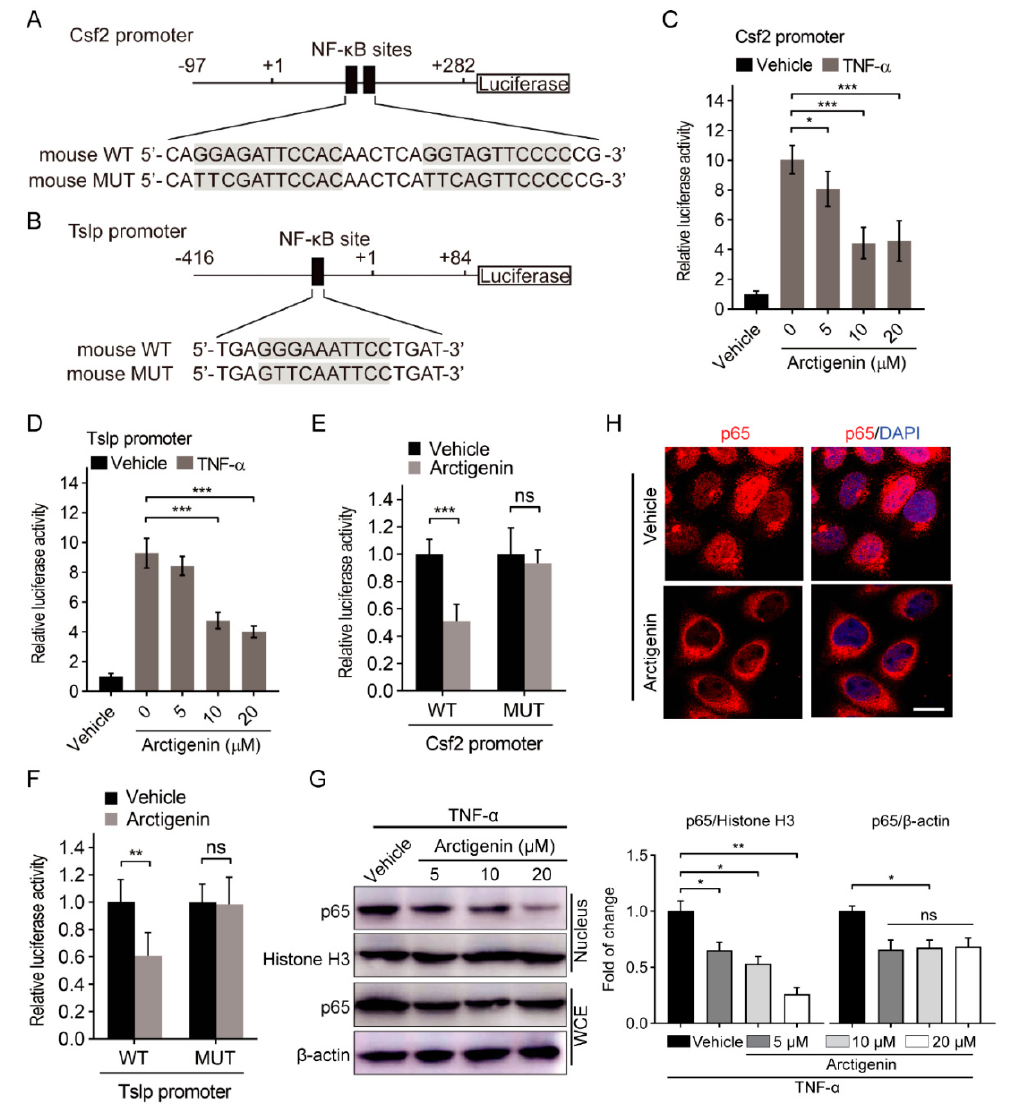
Figure 3. Arctigenin decreases the promoter activities of GM-CSF and TSLP through inhibiting the nuclear translocation of NF- κ B p65. ( A , B ) Wild type ( A ) or mutated ( B ) NF- κ B binding site in the constructed mouse Csf2 and Tslp promoters. Mutant sequence was highlighted by gray box. ( C , D ) The promoter activities of mouse Csf2 ( C ) and Tslp ( D ) in TNF- α -stimulated 4T1 cells treated with vehicle or arctigenin were measured by luciferase reporter gene assays. ( E , F ) The activities of wild-type (WT) or mutated (MUT) mouse Csf2 promoters ( E ) and Tslp promoters ( F ) were measured by luciferase reporter gene assays. ( G ) Western blot analysis of p65 expression in the nucleus and whole cell extract (WCE) of TNF- α -stimulated 4T1 cells. ( H ) Representative immunofluorescence staining of p65 in TNF- α -stimulated 4T1 cells treated with vehicle or arctigenin. DAPI counterstaining (blue) are used to indicate nucleus. Scale bar, 20 µ m. For ( C , D , G ), * p < 0.05, *** p < 0.001 (One-way ANOVA). For ( E , F ), ns, not significant, p > 0.05, ** p < 0.01, *** p < 0.001 (Student’s t test). Values represent mean ± SEM of three independent experiments.